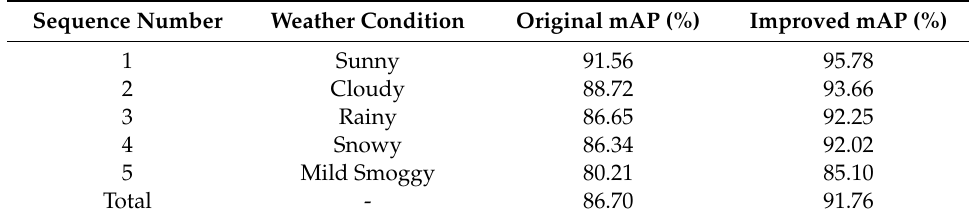
Table 2. The vehicle detection test results under di ff erent weather conditions.